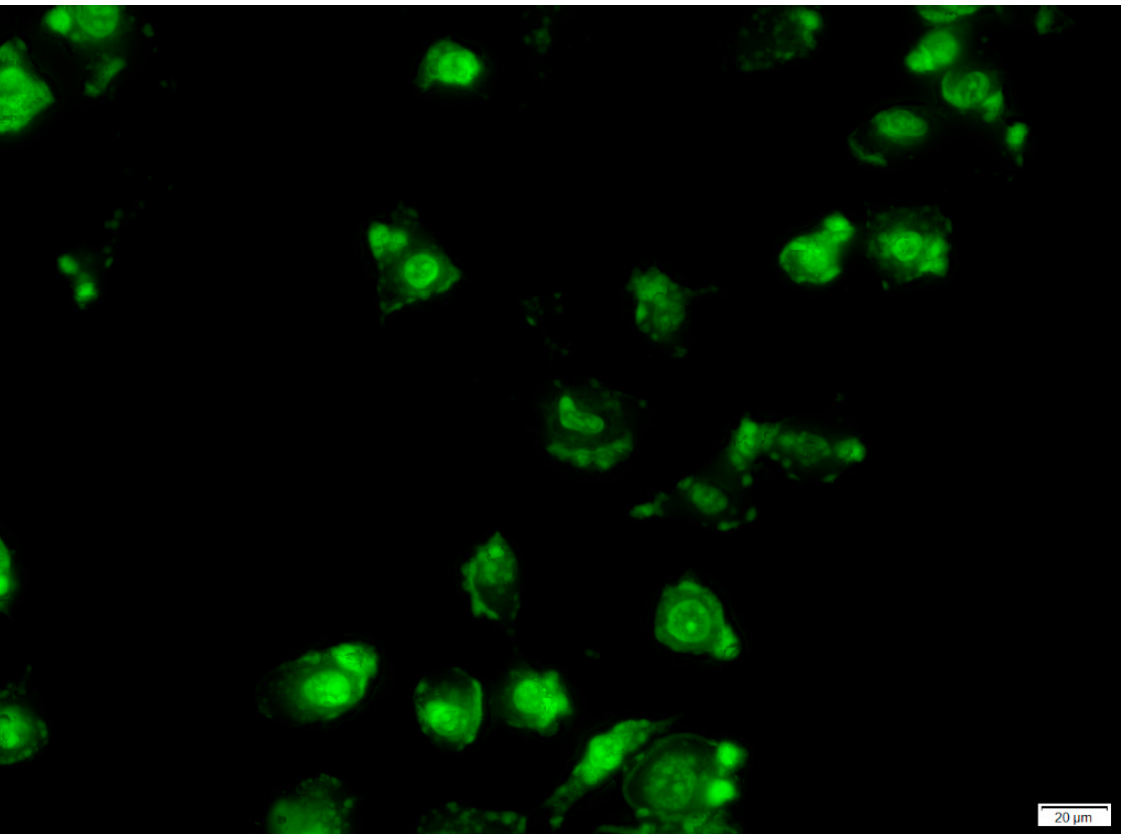
Figure 5. Confocal laser scanning microscopy (CLSM) micrograph showing cellular uptake and inter- nalization of the LyP-1-enhanced ENT-loaded nanosystem. Nanoparticles were labelled with FITC.